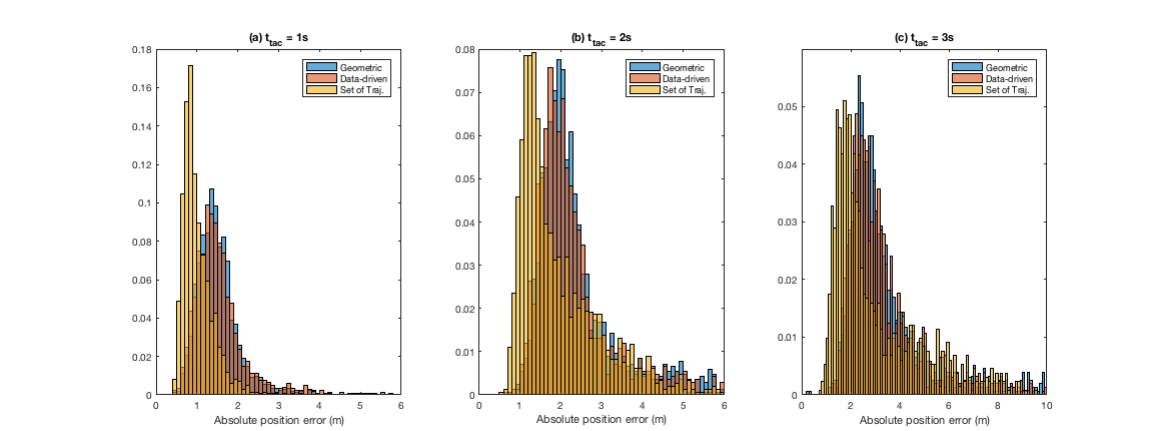
Figure 7. State prediction. Normalised histograms for mean absolute position error: ( a ) prediction time t tac = 1 s; ( b ) t tac = 2 s; and ( c ) t tac = 3 s. Note that the bin-size used for all the histograms is uniform, but for the sake of clarity the axes have been left non-uniform, and the histograms in ( b , c , have been truncated at 6 m and 10 m, respectively.